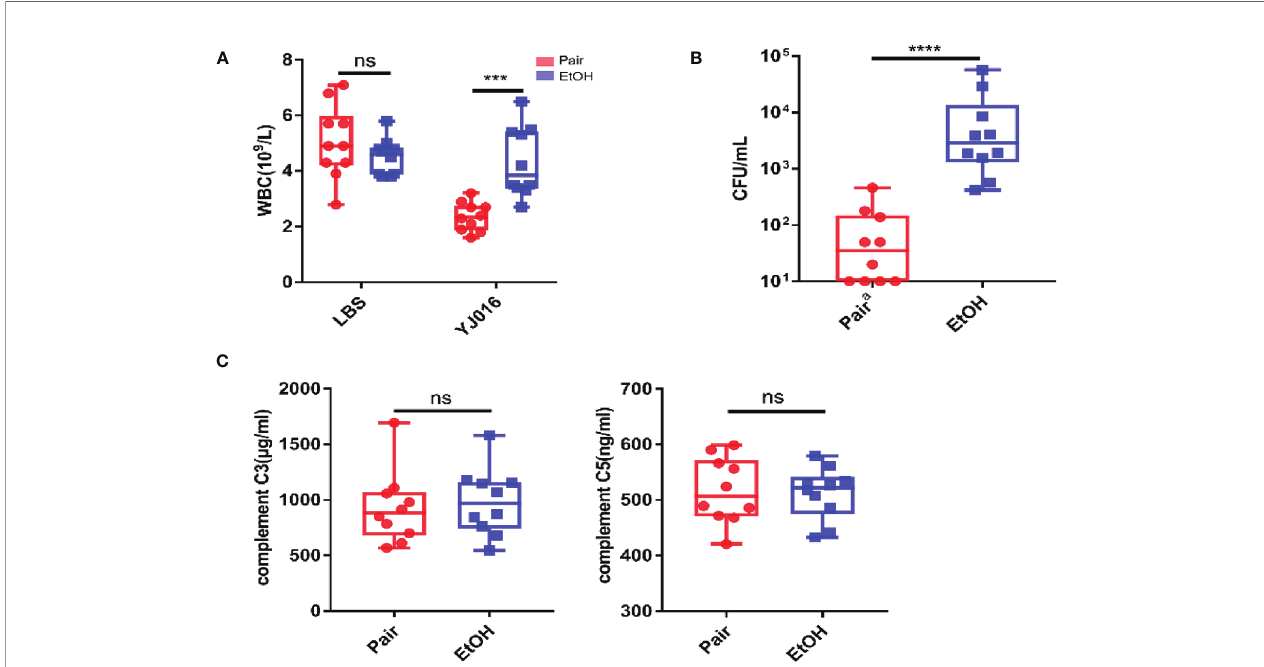
FIGURE 6 | Blood bacterial loads, blood counts, plasma complement. (A) Blood bacterial loads in the Pair and EtOH groups (n = 10). (B) White blood cellcounts in the Pair andEtOH groups (n= 10).The number of whiteblood cells decreased signi fi cantly inthe Pair group compared with the EtOH group post-infection. (C) Plasma complement C3 andC5 concentrationsinthe Pair and EtOH groups (n = 10). There was nostatistically signi fi cant difference in complement C3 andC5 between the Pair and EtOH groups. (ns. P > 0.05, *** P < 0.001, **** P <